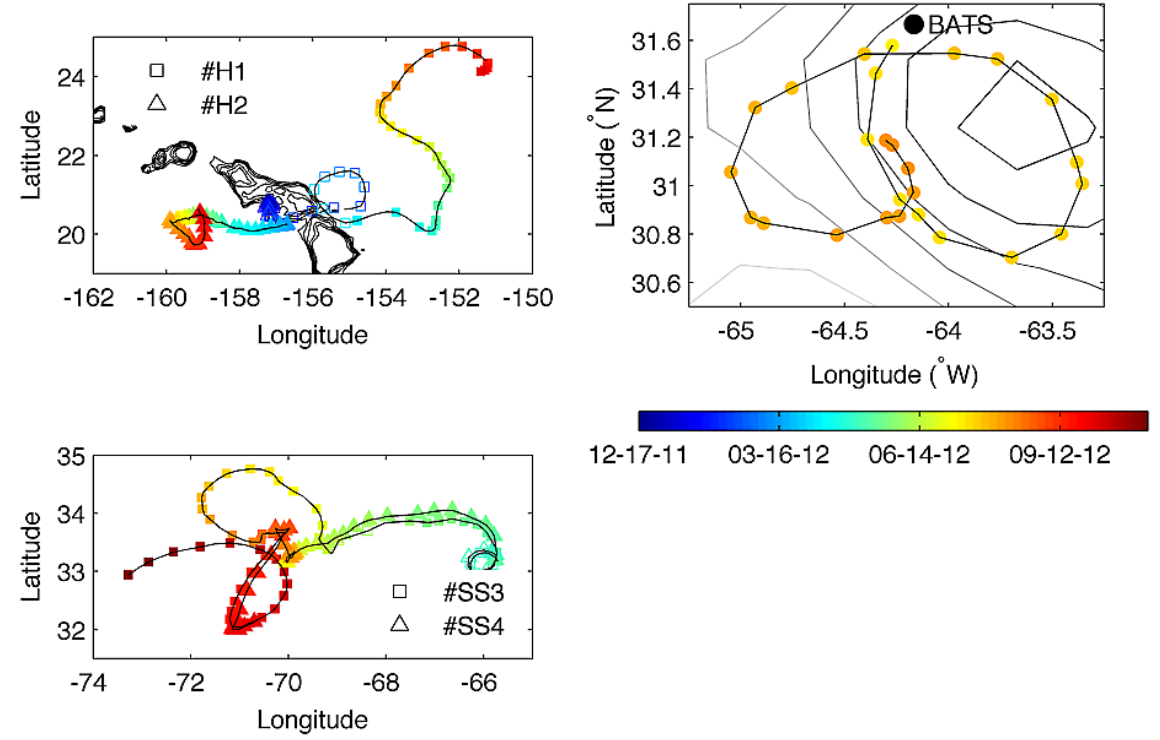
Fig. 1. Float paths and sampling dates. Deployment parameters are summarized in Table 1. Time color scale applies to all panels. Upper left: floats H1–H2 near Hawaii. Every 3rd surfacing location shown for clarity. Depth contours are shown every 500m from 2000m to the surface; open symbols denote profiles in water < 2000m deep or profiles to shallower than 1000m. Lower left: floats SS3–SS4 in the western Sargasso Sea, symbols as in upper panel. Every other surfacing location is shown. Upper right: float B5 in the vicinity of the BATS site. The float was deployed at BATS (black circle) and moved counterclockwise along its path. SSH contour spacing is 5cm; contours show location of cyclonic mesoscale eddy on 8 July 2012, the week prior to deployment (data: